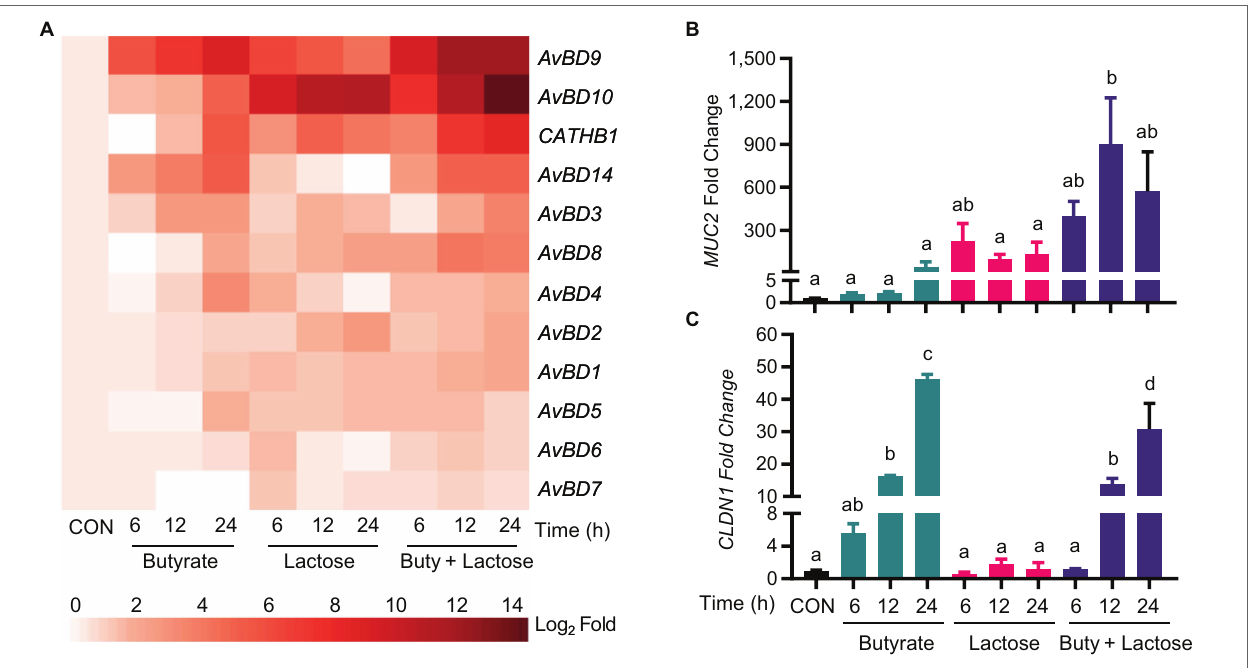
FIGURE 5 | Synergistic induction of HDP and barrier function gene expression by butyrate and lactose. Chicken HD11 cells were stimulated in duplicate with 2 mM sodium butyrate and 0.2 M lactose individually or in combination for 6, 12, or 24 h, followed by RNA isolation and RT-qPCR analysis of the mRNA expression levels of multiple HDP genes (A) , mucin 2 ( MUC2 ) (B) , and claudin 1 ( CLDN1 ) (C) . Results are expressed as means ± SEM of two independent experiments. The bars without common superscript letters denote statistical significance ( p < 0.05) as determined by one-way ANOVA and post hoc Tukey’s